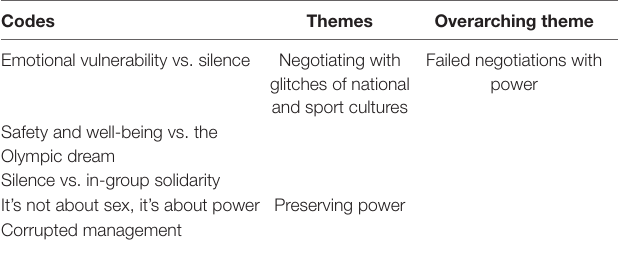
TABLE 2 | Thematic map of overarching theme failed negotiations with power illustrating socio-cultural elements that shelter sexual abuse of female athletes in